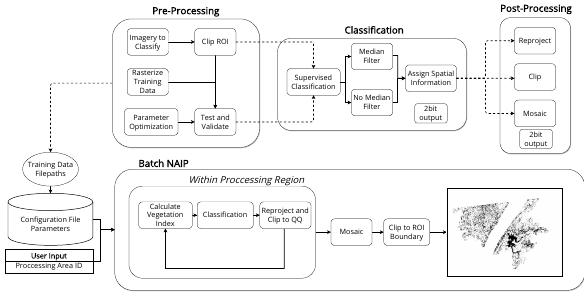
Figure 1. Workflow of